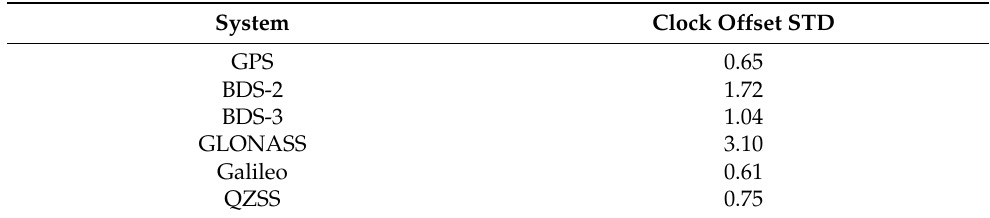
Table 3. Clock offset accuracy of each system (units: